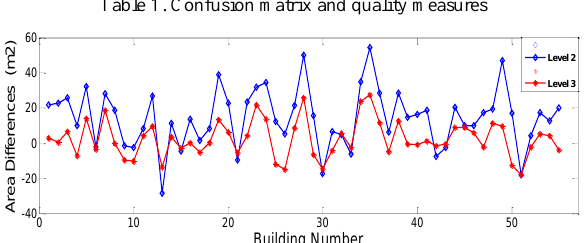
Table 1. Confusion matrix and quality measures